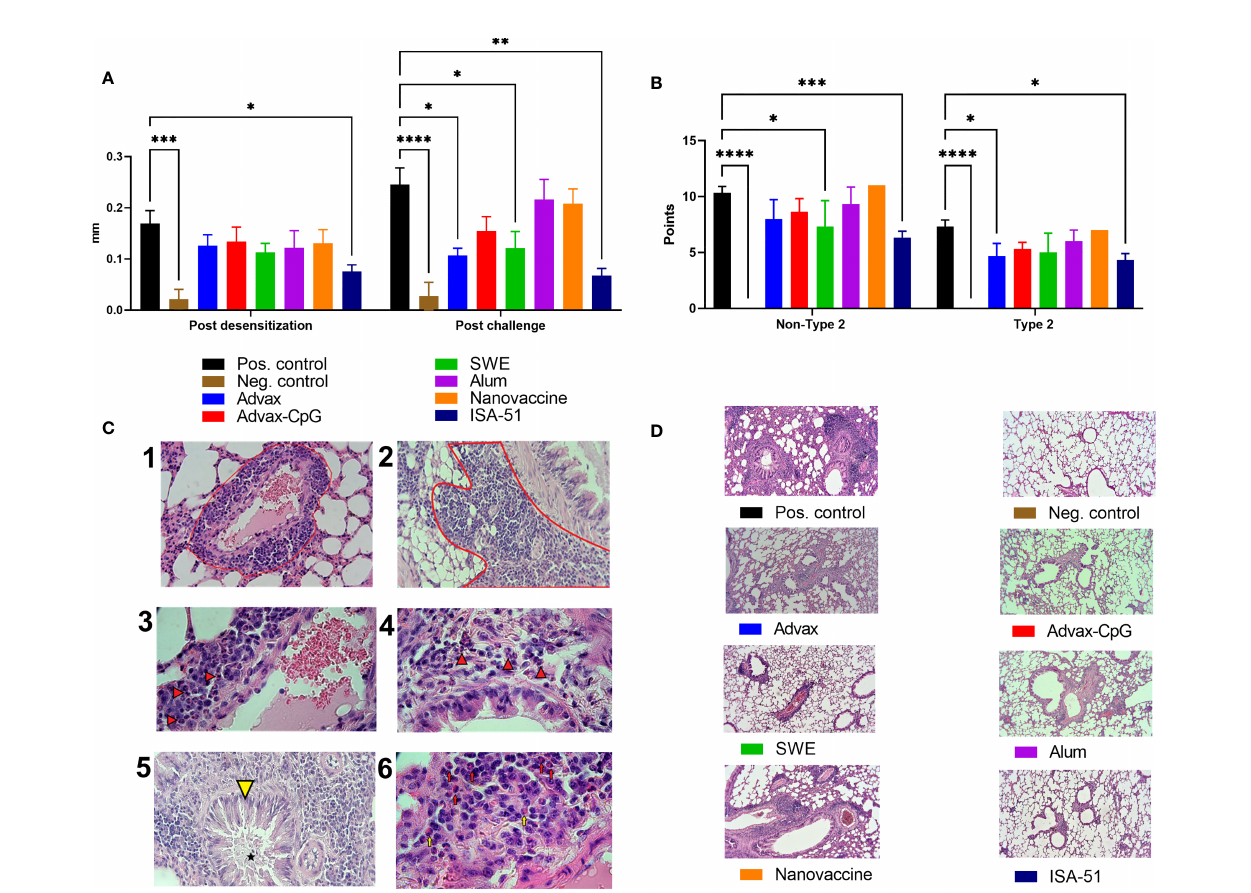
FIGURE 5 | Ef fi cacy of ASIT in BALB/c mice as assessed by ear swelling test (A) and histological analysis of the lungs (B, D) . The ear swelling test was performed after ASIT and challenge and the analysis of pathological changes in the lungs of mice after intranasal challenge with wormwood pollen extract. The results of the ear swelling test are presented as the difference in the thickness of the mouse auricles with and without the allergen/PBS injection expressed in mm. Histological analysis of lung samples after challenge was performed according to two scales: all pathological changes (maximum 16 points, Non-Type 2 in fl ammation) and in the absence of neutrophils (maximum 12 points; classic allergic Type 2 in fl ammation). We present representative pictures of the lungs from different groups at a magni fi cation ×100 (C) . – 1 - Perivascular in fl ammation (red outline, ×400); – 2 - Peribronchial in fl ammation (red outline, ×400); – 3 - neutrophils (arrows) as part of the perivascular in fl ammation, ×1,000; – 4 - Neutrophils (arrows) as part of the peribronchial in fl ammation, ×1,000; – 5 - Metaplasia of goblet cells (yellow arrowhead) and mucus accumulation (asterisk) in the bronchiolar cavity, ×400; – 6 - Neutrophils (red arrows) and single eosinophils (yellow arrows) in the perivascular in fl ammatory in fi ltrate, ×1,000. Differences in studied parameters between groups were assessed using S ̌ ı ́ da ́ k ’ s multiple comparisons test. P < 0.05 value was considered signi fi cant. *P < 0.05, **P < 0.01, ***P < 0.001, and ****P <